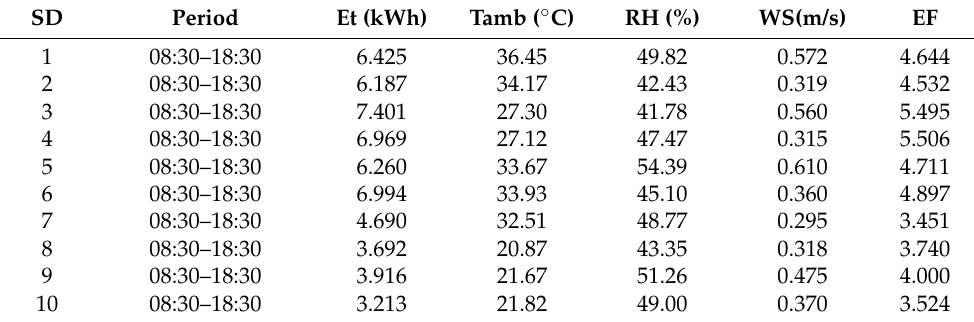
Table 7. Validation dataset of predictors and desired output of the hybrid DX-SAHP system.